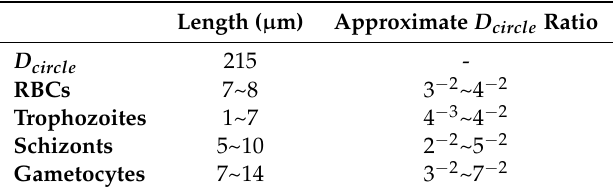
Table 2. Maximum length and respective D circle relative ratios of RBCs’ and MPs’ structures